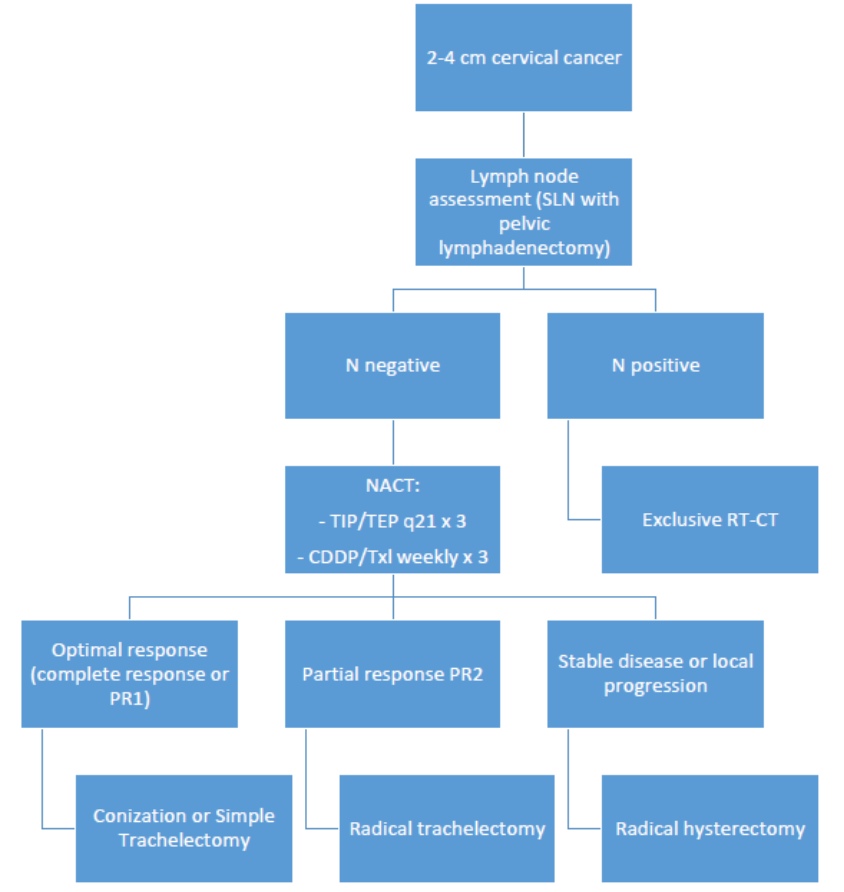
Figure 2. Decision-making process algorithm for women with IB2 cervical cancer. SLN = sentinel lymph node. N = lymph nodes. NACT = neoadjuvant chemotherapy. RT-CT = radiochemotherapy. TIP = cisplatin-paclitaxel-ifosfamide. TEP = cisplatin-paclitaxel-epirubicin. CDDP/TXL = cisplatinum-paclitaxel.